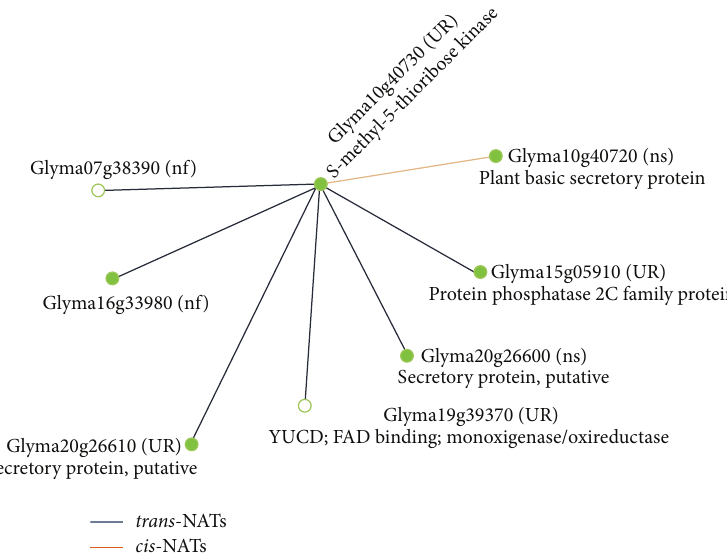
Figure 3: NAT pairs ( cis and trans ) involving soybean Glyma10g40730 and others transcripts, in association with the regulation observed with SuperSAGE unitags mapped in the respective transcripts. Adapted from the Network Viewer/PlantNATsDB database. UR: upregulated (in soybean leaves infected with Phakopsora pachyrhizi versus mock control); ns: no differentially expressed ( 𝑃 < 0.05 ); nf: not found. Green circles: NATs that do not have another antisense relationship with any other locus. White circle: NATs that have other antisense relationships.